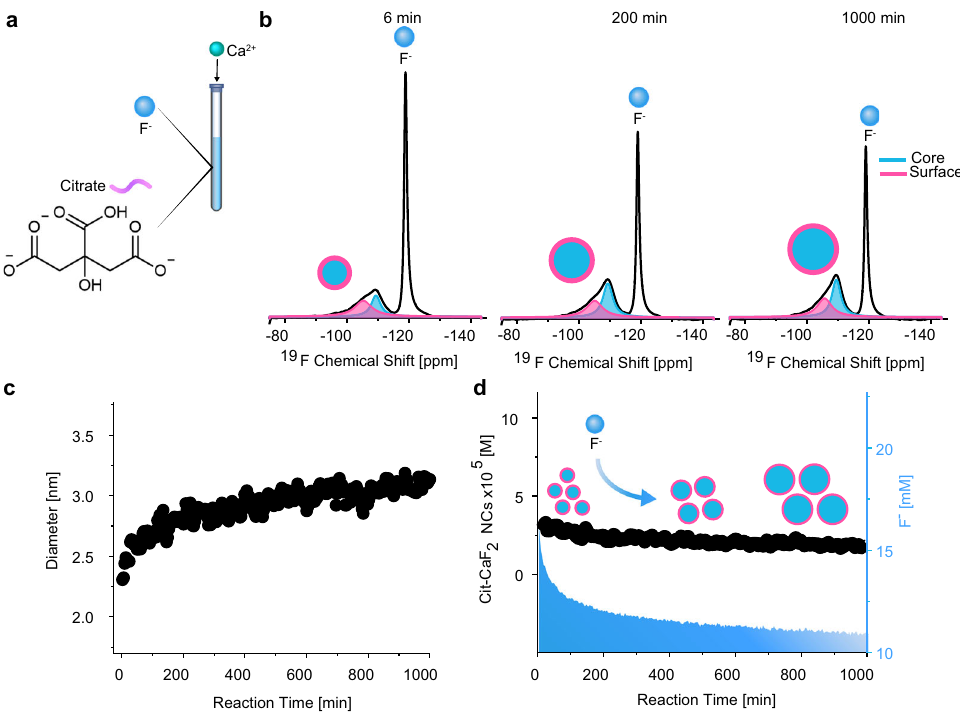
Fig. 4 Ligand effect on CaF 2 NC ’ s growth mechanism. a Schematic illustration of the real-time synthesis of Cit-CaF 2 NCs in water and of the molecular structure of citrate. b 19 F-NMR spectra from three different time points during the reaction (6 min, 200 min, and 1000 min), showing the deconvoluted signals of 19 F atoms on the surface (pink) and in the core (blue) in addition to the peak at − 120 ppm assigned to free F - ions. c Size evolution of Cit-CaF 2 NCs in water from a real-time, high-resolution 19 F-NMR data set. d Concentration of Cit-CaF 2 NCs (multiply by 105 in the graph) in water (left axis, black) or F - ion consumption (right axis, light blue) as a function of the reaction time.